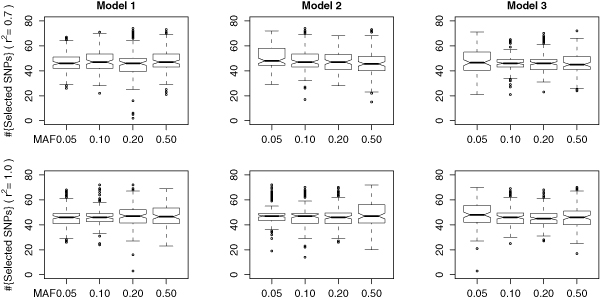
Number of SNP markers selected by epi Forest. The median of the number of markers selected by the sliding window sequential forward feature selection (SWSFS) algorithm is around 45, while the maximum is in general less than 80, suggesting the capacity of the SWSFS algorithm.